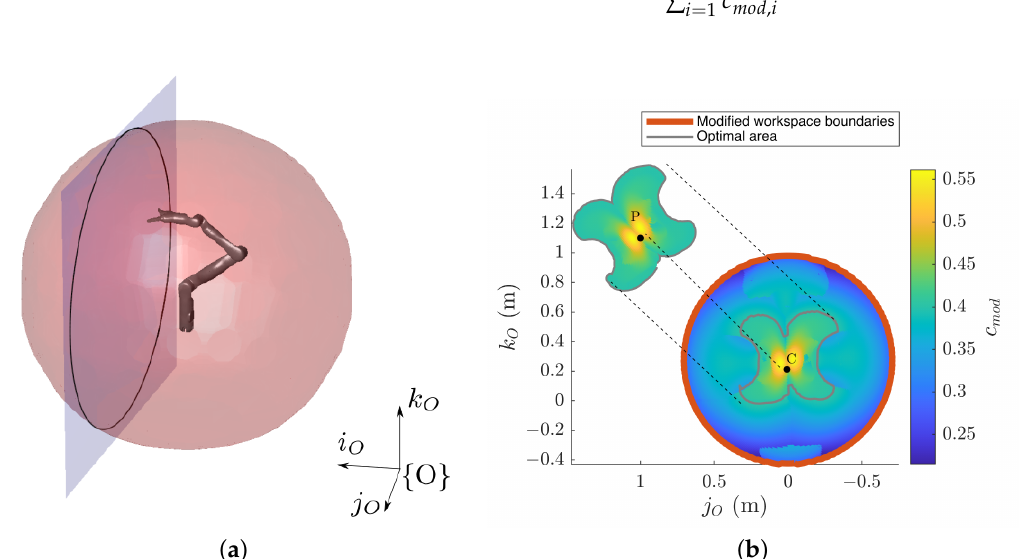
Figure 8. ( a ) Manipulator workspace representation (red volume) and extraction of the plane of interest (blue). Since no motion is enabled along the i O axis, the x off-set of the plane with respect to { O } is the x coordinates of the target point P . ( b ) Optimal manipulability area identification (inside the gray line). The total workspace is reduced due to the orientation specification, thus obtaining the area inside the red circle that, in general, does not coincide with the black circle in ( a ). The optimal area is then moved and rotated according to Figure